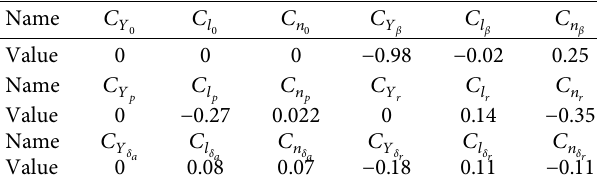
Table 2: UAV aerodynamic